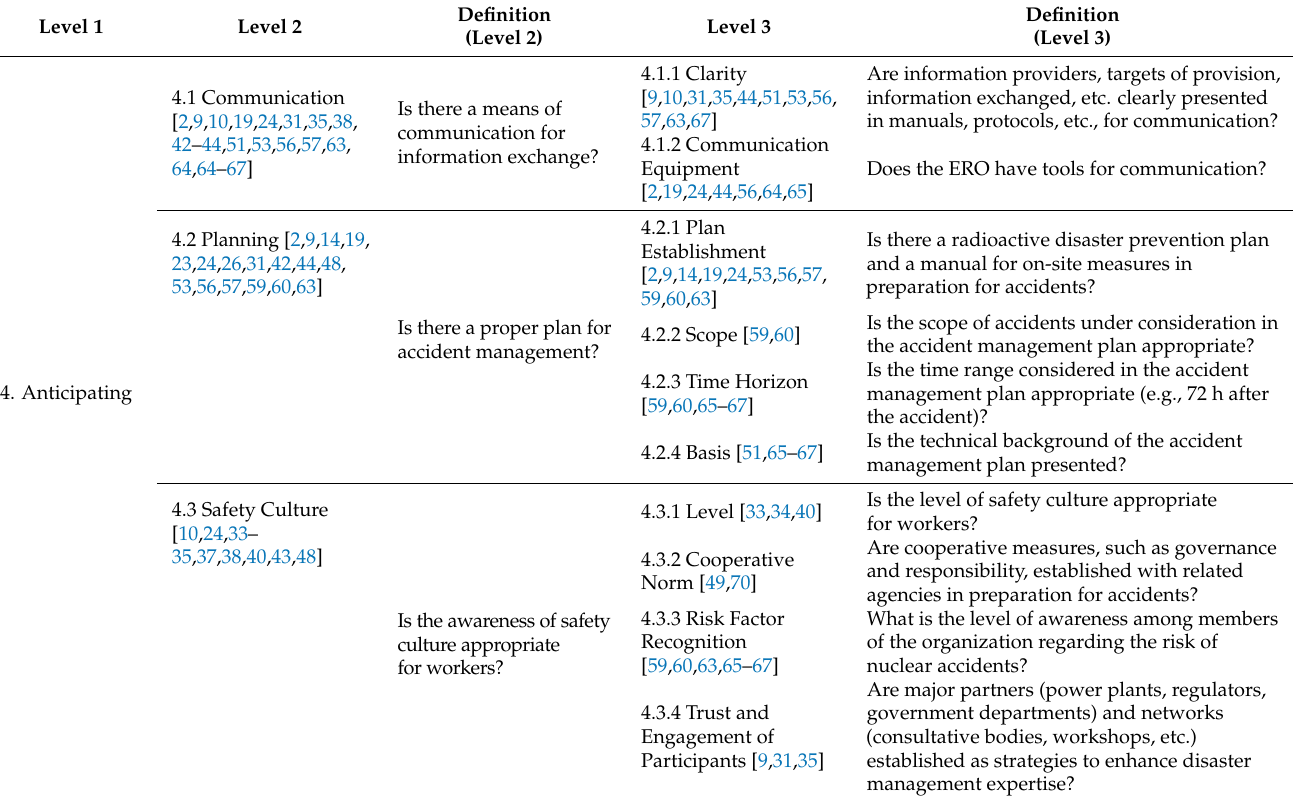
Table 11. Definitions and contributing factors for anticipating